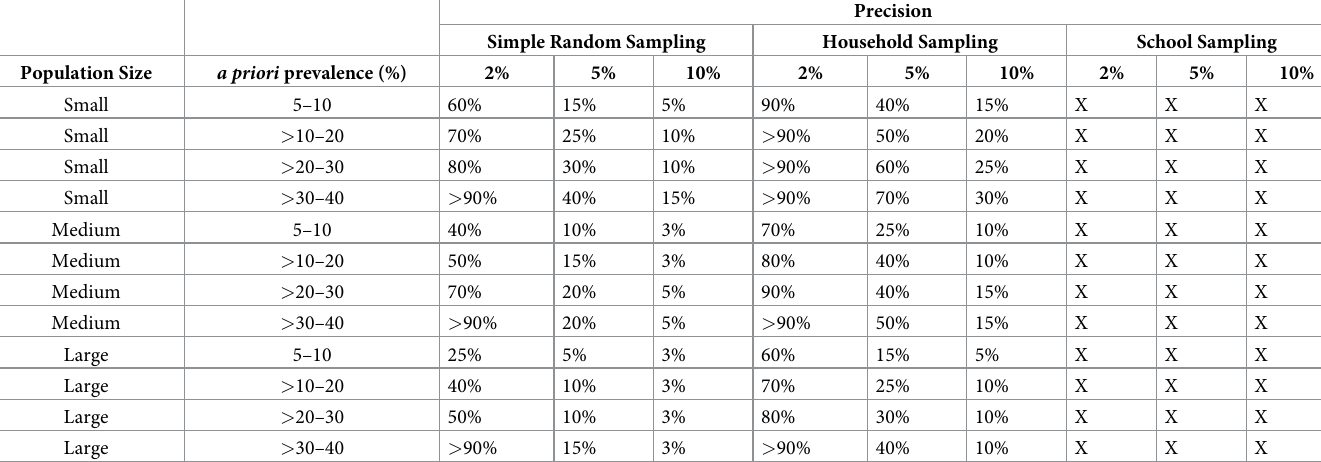
Table 2. Required sample sizes estimated from simulation results for the simple random, household, and school sampling methods to achieve a given precision, combined across all scabies assignment methods. Precision Simple Random Sampling Household